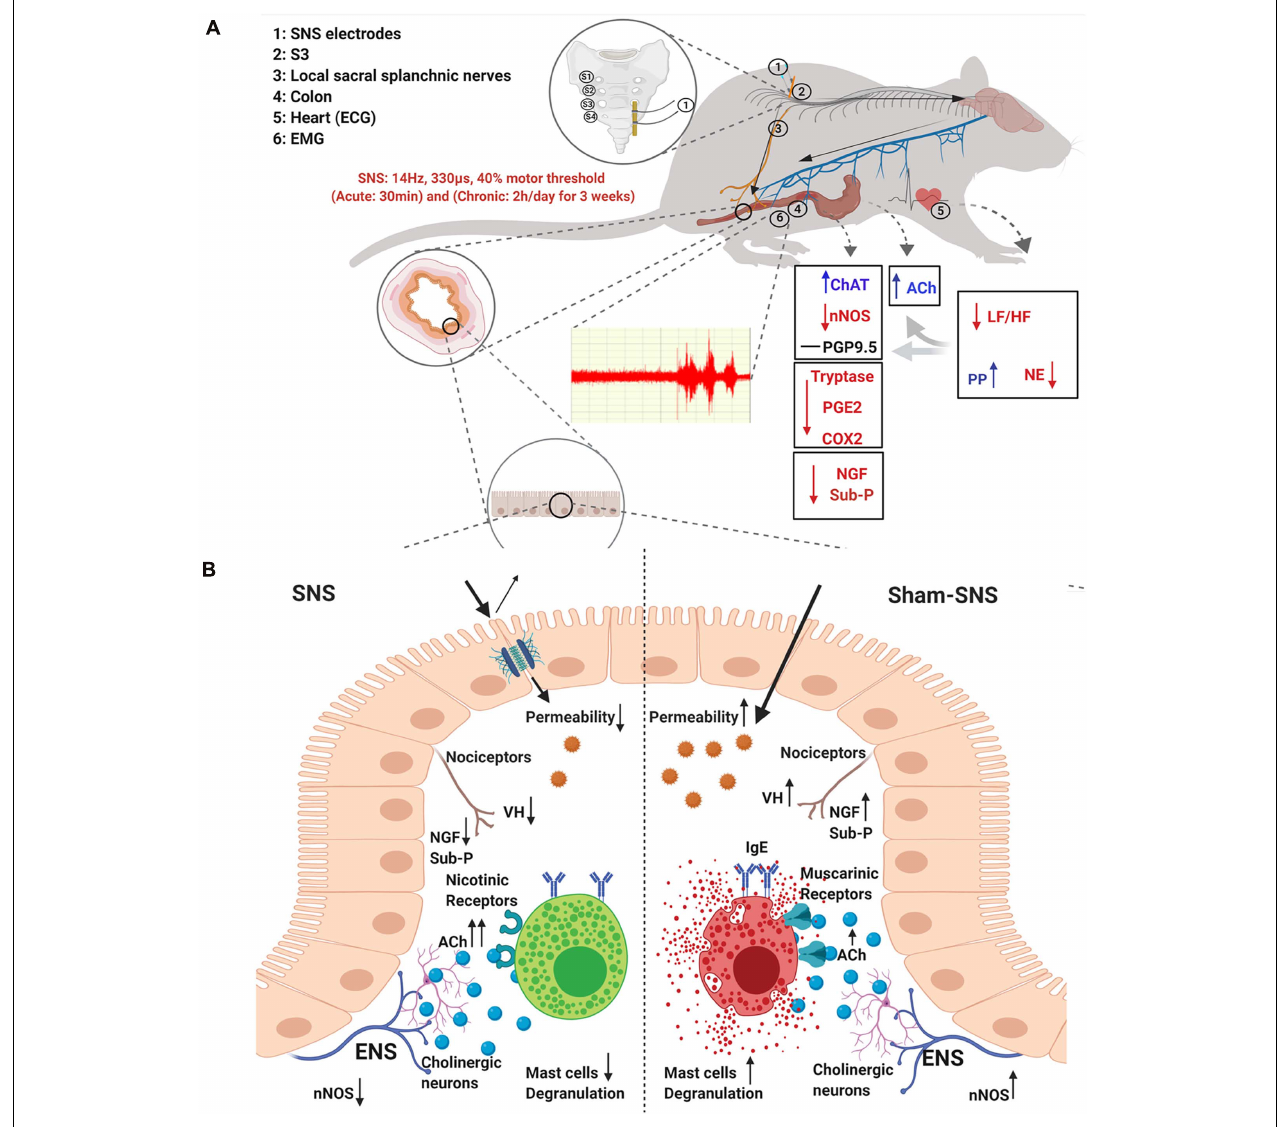
FIGURE 9 | Schematic figure of the possible mechanism of effects of SNS on VH. (A) Possible extrinsic afferent circuitry. (B) Possible intrinsic